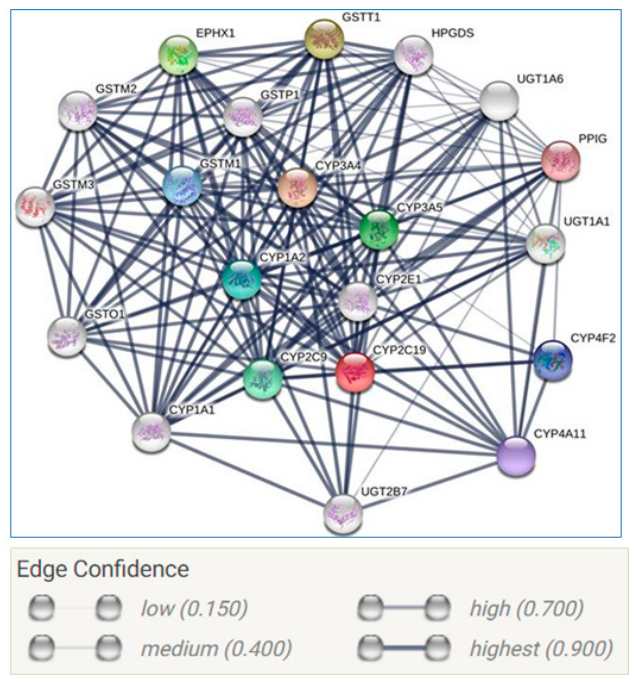
Figure 4. Gene network for the CYP2C19 gene and selected interacting protein using STRING software utilizing version 10.5. STRING is a biological database and web resource of known and predicted protein–protein interactions, and imports data from experimentally derived protein–protein interactions through literature curation. Furthermore, STRING also stores computationally predicted interactions using text mining of scientific texts, interactions computed from genomic features, and interactions transferred from model organisms based on orthology. All predicted or imported interactions are benchmarked against a common reference of functional partnership as annotated by KEGG (Kyoto Encyclopedia of Genes and Genomes).